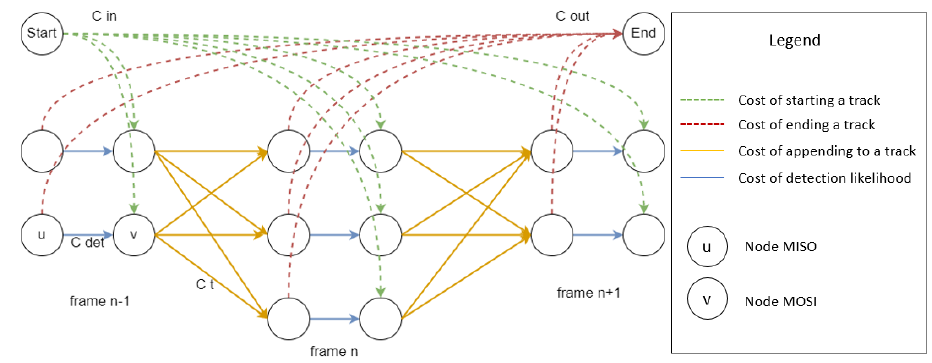
Figure 4. Multi-partite graph layout for multi-object